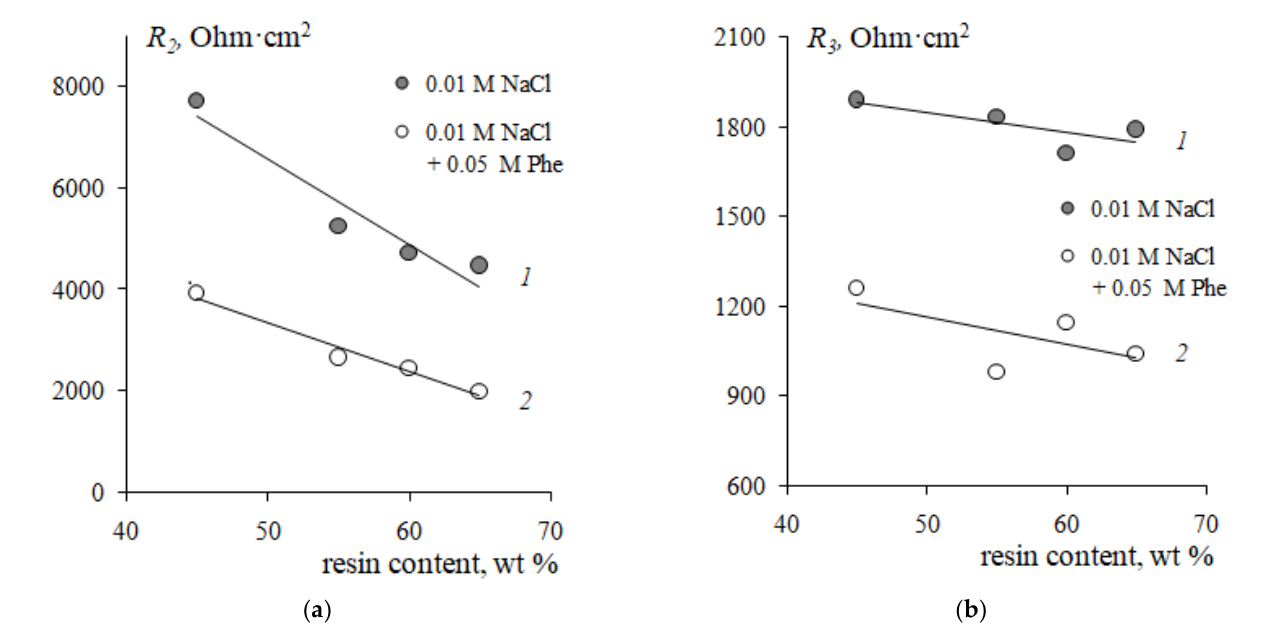
Figure 11. Dependences of the resistances of the second (limiting) R 2 ( a ) and the third (underlimit- ing) R 3 ( b ) sections of CVCs of cation-exchange membranes in 0.01 M NaCl solution ( 1 ) and the mixed 0.01 M NaCl + 0.05 M Phe solution ( 2 ) on the resin content.